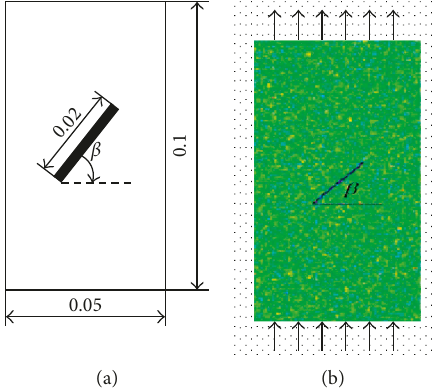
Figure 3: Model schematic diagram and RFPA model diagram under uniaxial compression. Table 1: The mechanical parameters of materials used in the model. Parameter